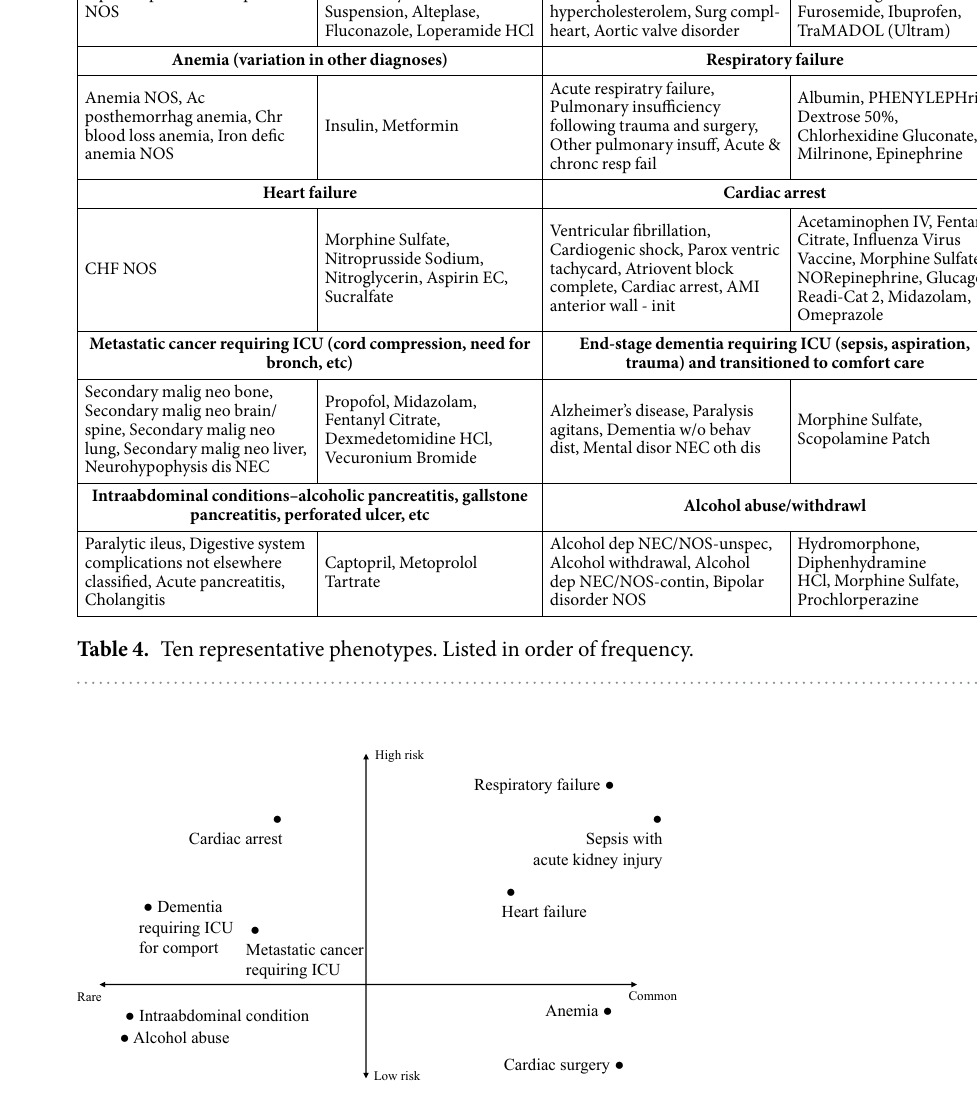
Figure 4. Phenotype maps. Phenotypes are positioned according to frequency and mortality